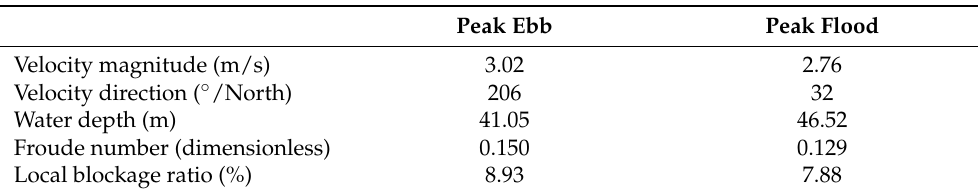
07:00 08:00 09:00 10:00 11:00 12:00 13:00 14:00 15:00 16:00 17:00 18:00 Figure 7. Time-series of the resistance coefficient K during a mean spring tide on 9 August 2014. The peak ebb and flood are represented by blue and red circles, respectively. Table 1. Characteristics of the flow during peak ebb and flood in the centre of the tidal farm (49.705 ◦ N; 2.103 ◦